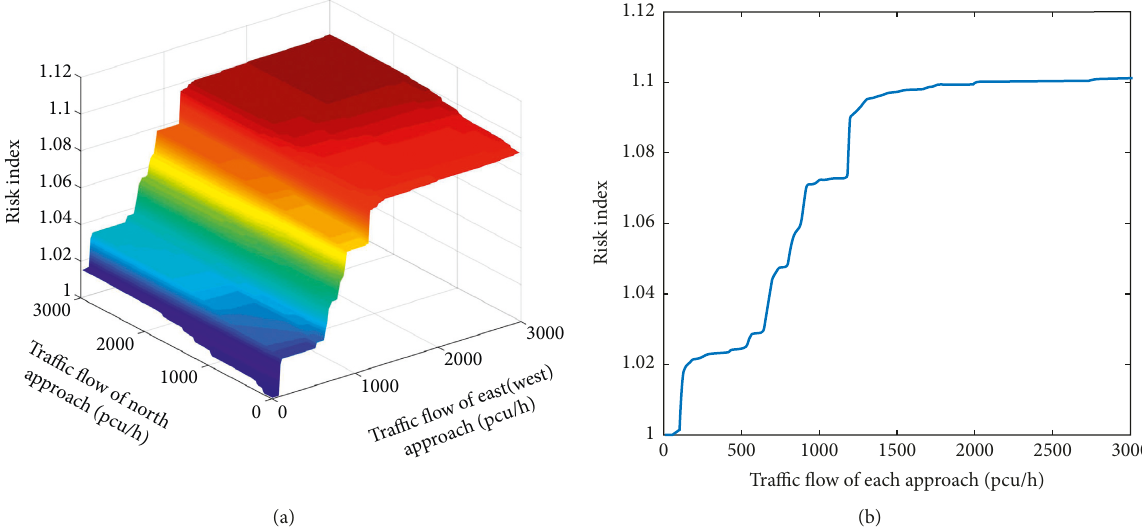
Figure 11: The relationship between risk index and traffic flow. (a) The relationship between risk index and the traffic flow of different approaches. (b) The relationship between risk factor and traffic flow of each